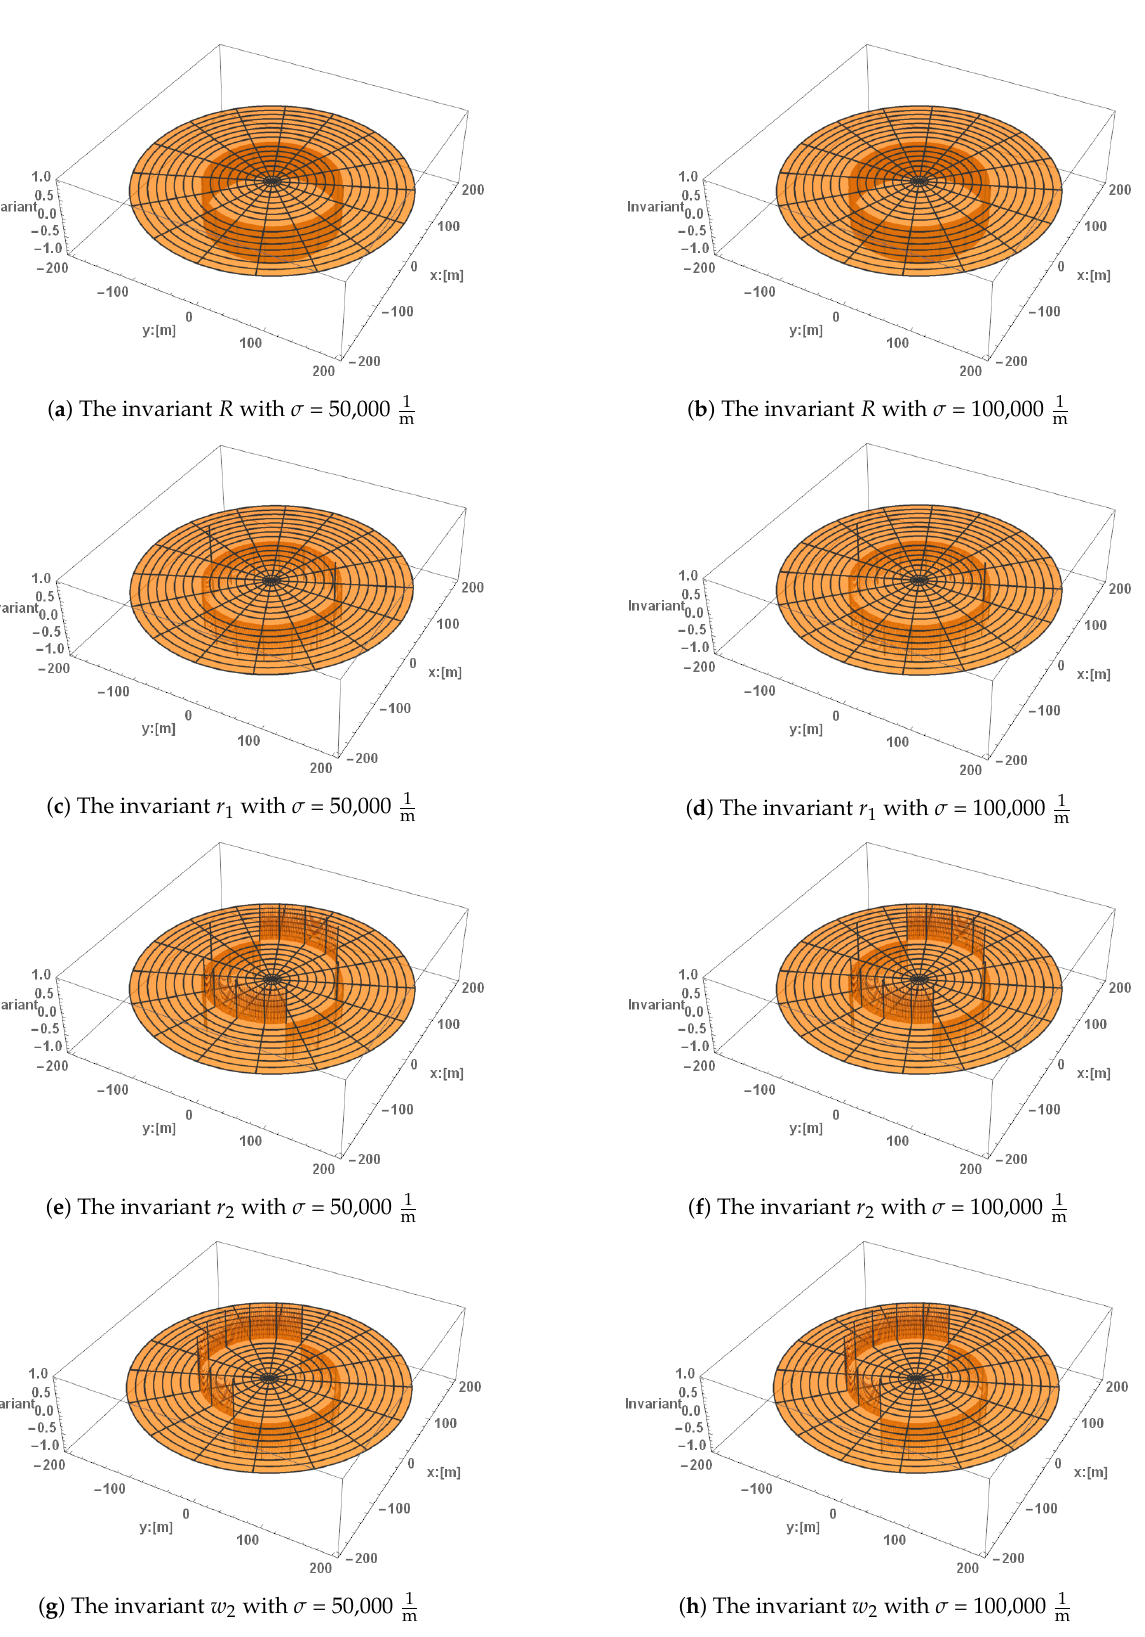
Figure A10. The warp bubble skin depth for R , r 1 , r 2 and w 2 for the Natário warp drive at a constant velocity. The other parameters were chosen to be v “ 1 c , and ρ = 100 m in natural